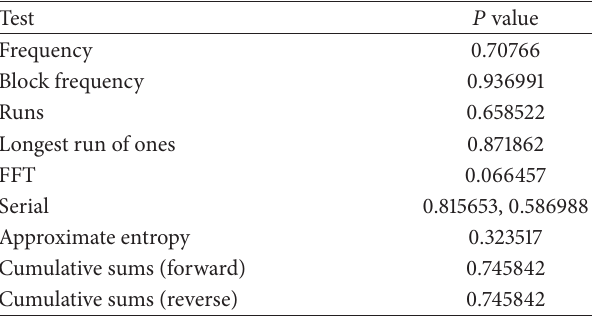
0.1925 . Under such a lost entropy rate, in order to generate a 256 -bit key, at least 317 common secret bits need to be collected. When the communication distance is 300 m and the round-1 block size is 10 , the lost entropy rate is 0.3203